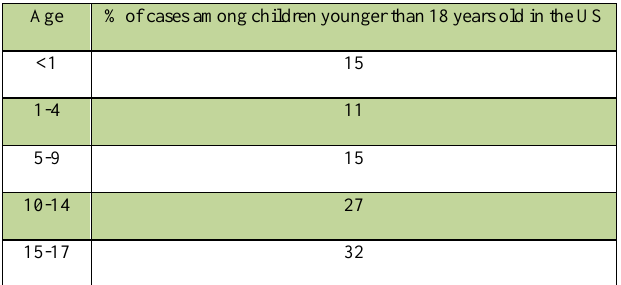
Table 2. Age distribution of cases among children aged <18 in the United